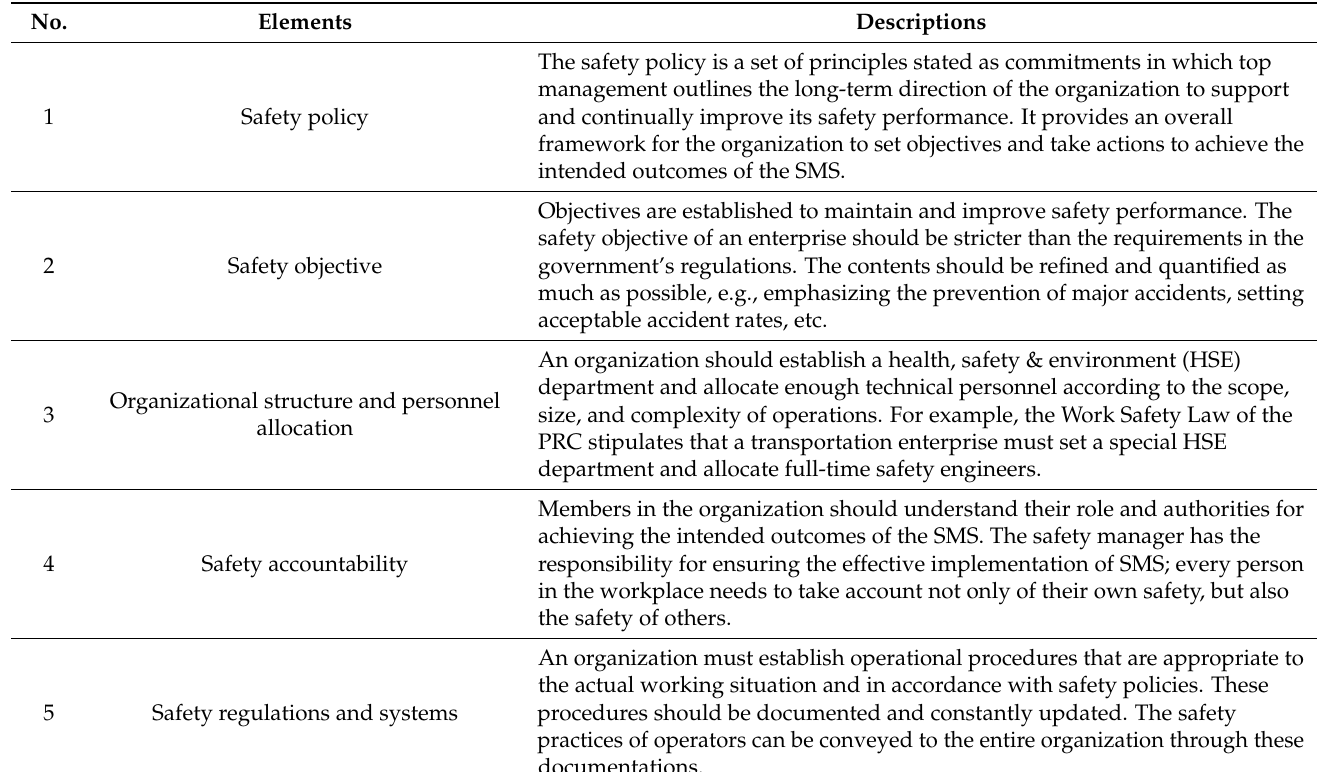
Table 2. Key elements in the development of safety management system